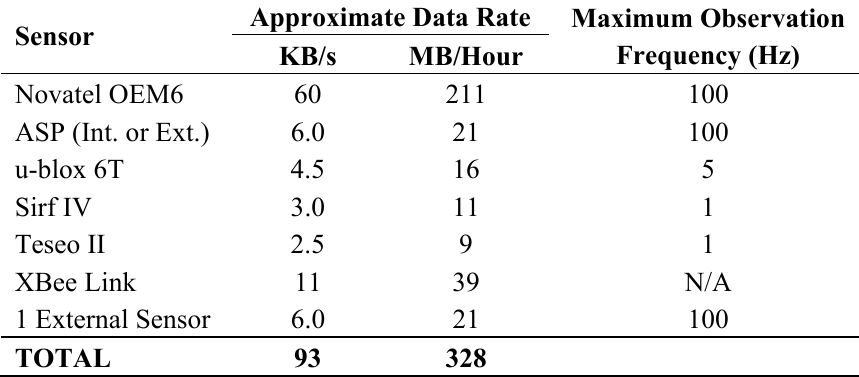
Table 4. NavCube Sensor Data